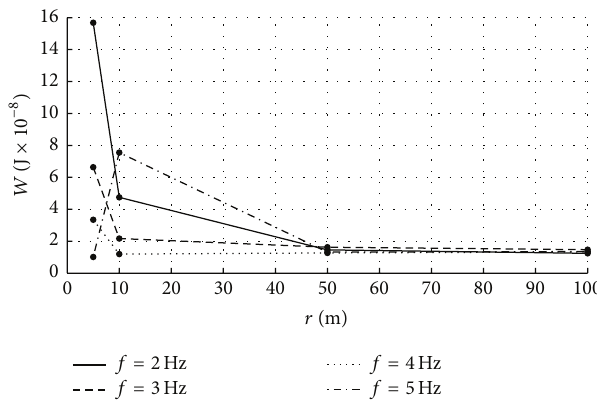
Figure 8: Radiated energy 𝑊 for different radii 𝑟 and frequencies 𝑓